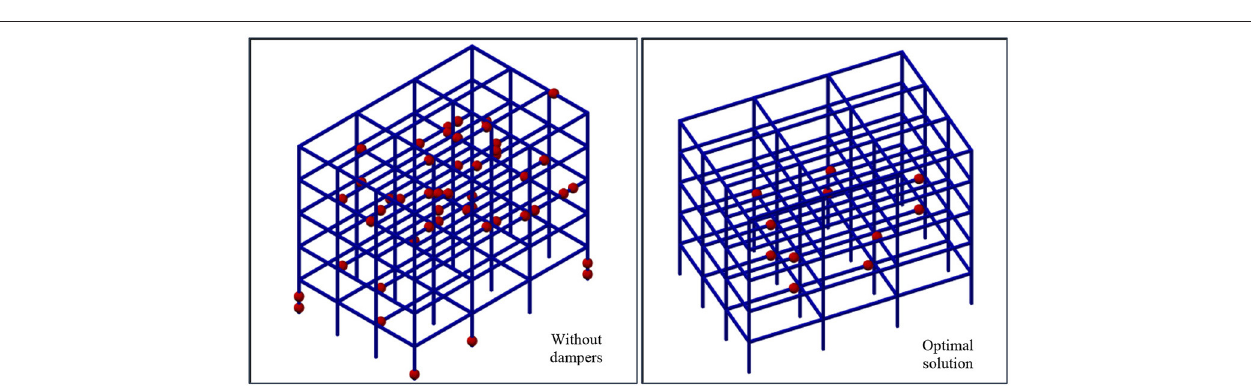
FIGURE 19 | Comparison between the response time histories of accelerations, interstory drifts of the structure without dampers (M0_0) and the structure with the optimal solution (C7_8 and C8_9) in X and Y directions.